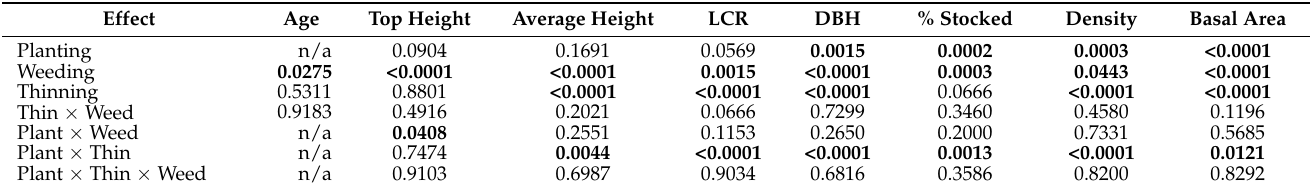
Table 2. Stand variables 17 growing seasons after planting: significance probabilities ( Prob > F values) of treatment